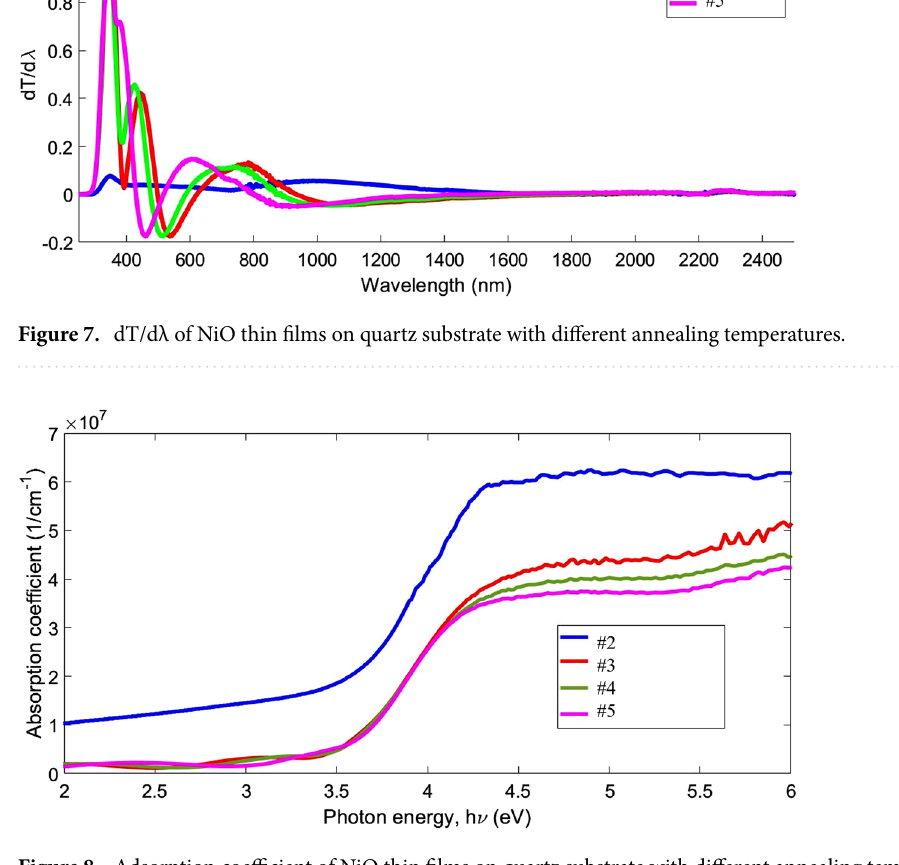
Figure 8. Adsorption coefficient of NiO thin films on quartz substrate with different annealing